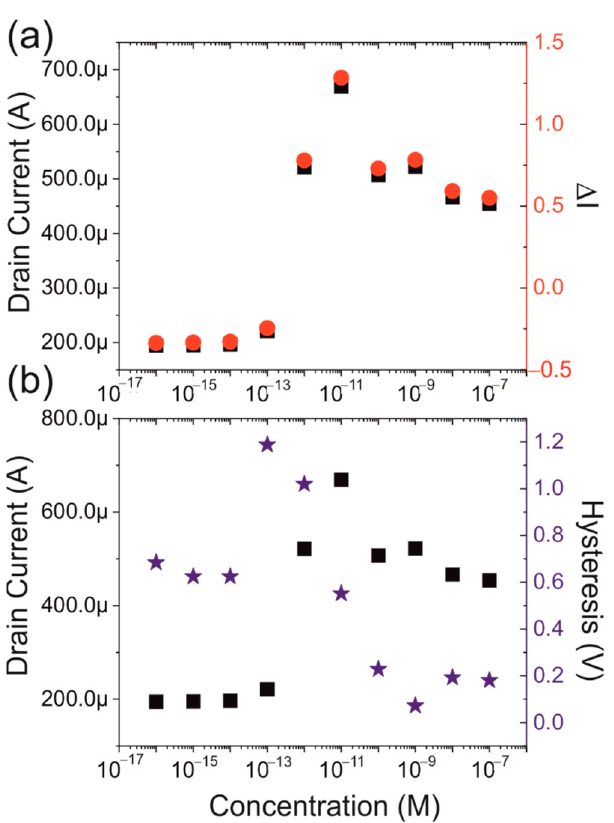
Figure 6. ( a ) comparison between the current at +3 V (black) and the relative change (red). ( b ) comparison between the current (black) and the hysteresis (blue).